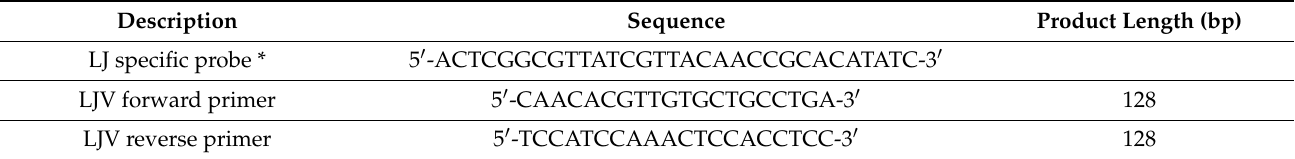
Table 1. Probes and primers used in this